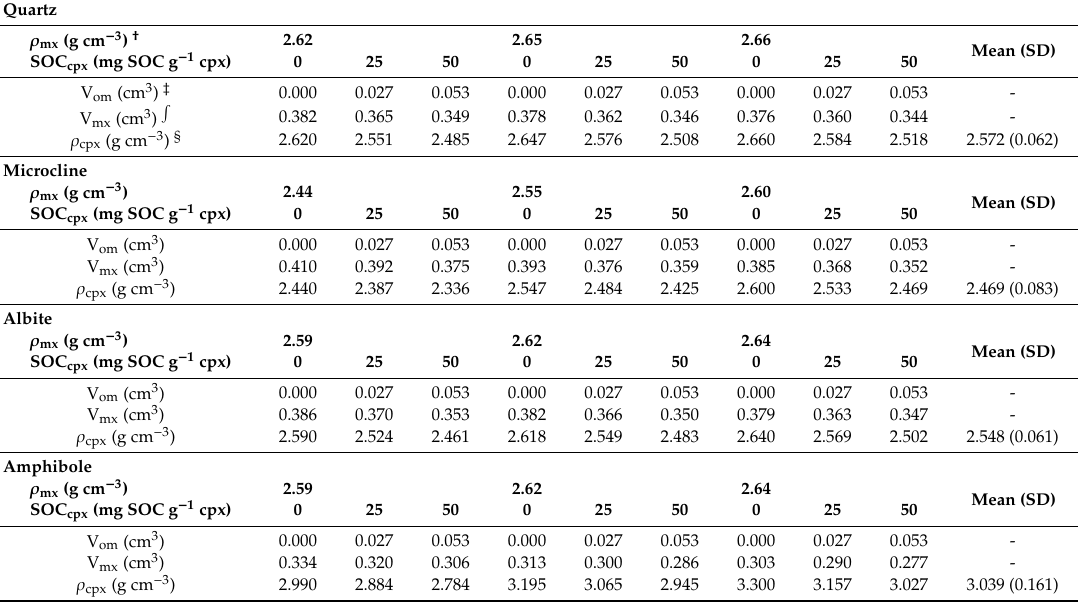
Table A1. Estimation of organo-mineral complex density for minerals having a low specific surface area. Quartz